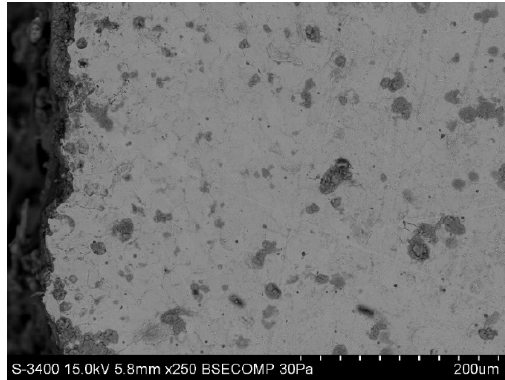
Figure 13. Hardening velocity diagram [11]